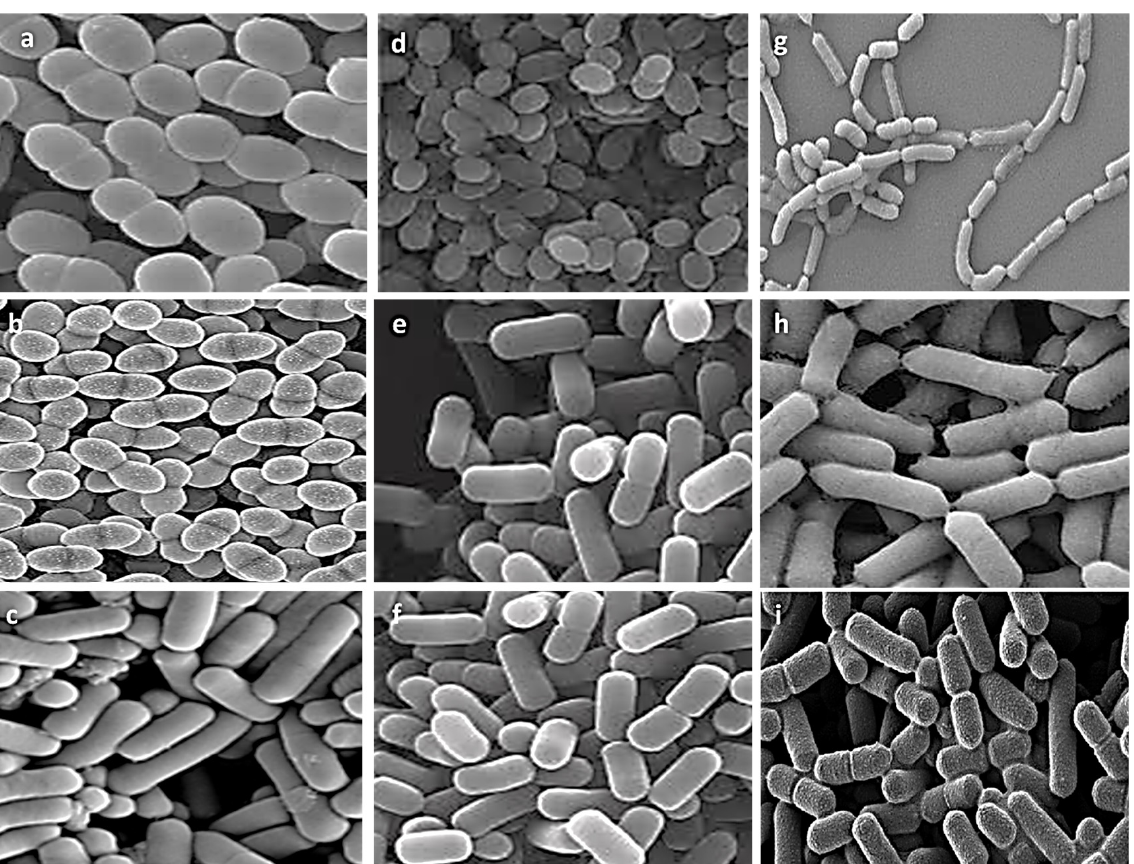
Figure 2. Scanning electron microscopy visualization of different isolates, ( a ) E. faecalis ASO44; ( b ) E. faecium ASO292; ( c ) L. delbrueckii ASO100; ( d ) L. lactis ASO26; ( e ) L. plantarum ASO50; ( f ) L. case ASO53; ( g ) L. rhamnosus ASO20; ( h ) L. gasseri ASO25 ( i ) L. paracasei ASO32. Images were captured at an excitation voltage of 20 K.V., at 5000 magnification with a working distance of 13.7–14.2